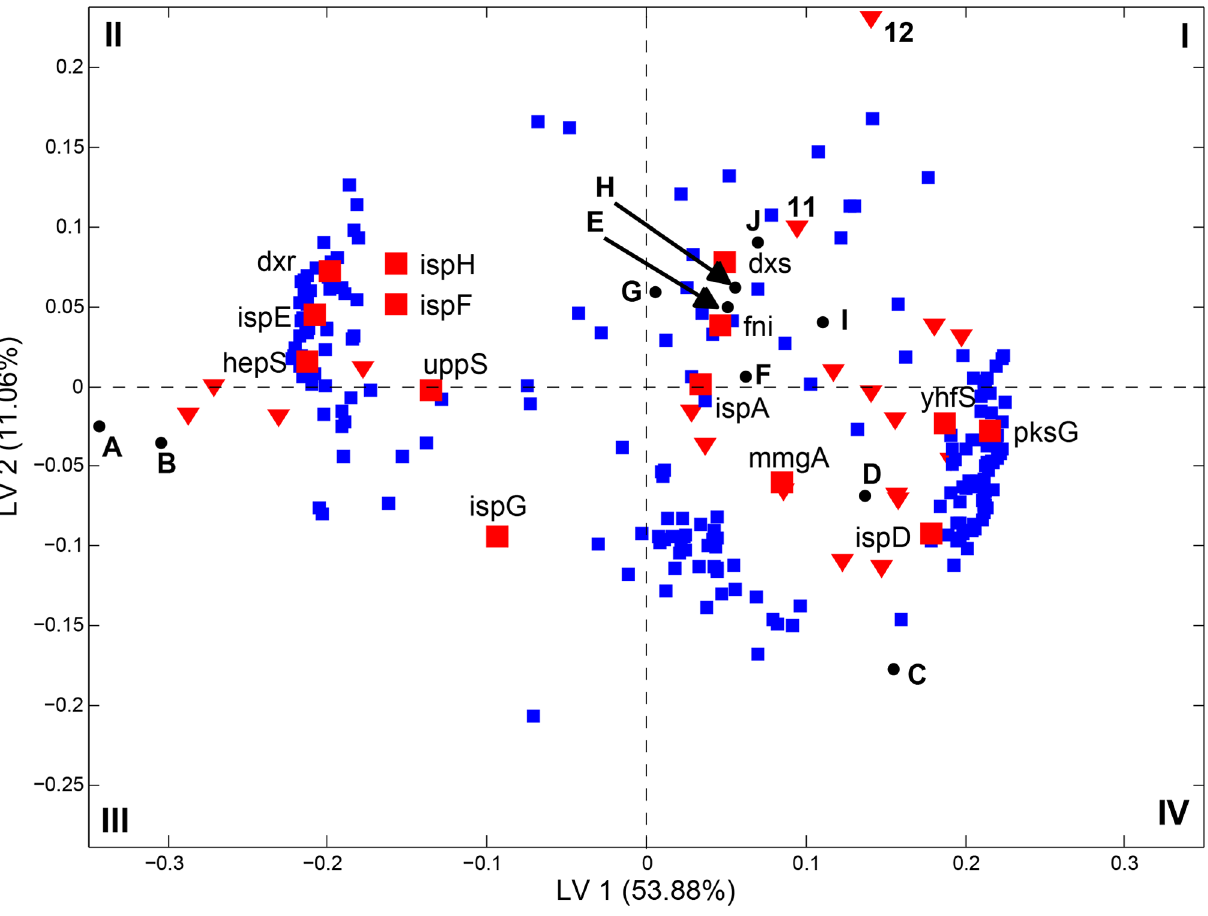
Figure 8. Gene expression levels are predictive of isoprene production in a PLSR model. A total of 213 genes were used in the analyses. Genes (squares), terpenoid genes (red squares), training set perturbations (red triangles), and test set perturbations (closed circles) are indicated in the plot. LV1 and LV2 indicate the latent variable values for each axis, with the percent variance in isoprene captured by the model indicated in parentheses. Perturbation abbreviations for the training set are labeled A through J and two perturbations for the testing data set are labeled as 11 and 12. Abbreviations: A, 2% acetic acid; B, 2% lactic acid; C, 1% ethanol; D, 0.2 mg/mL indole; E, DMSO; F, OX- ispA ; G, OX- fni , H, empty vector; I, wild type control; J, OX- dxs ; 11, 0.005% H 2 O 2 ; 12, 0.02% H 2 O 2